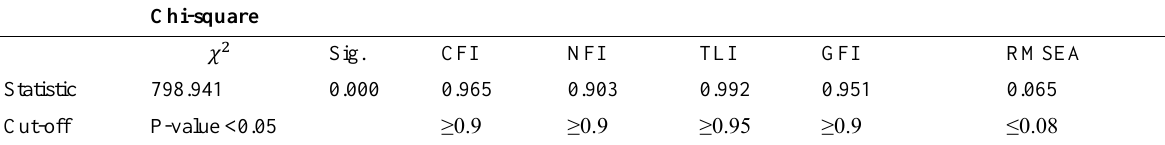
Table 2: Fit indices;